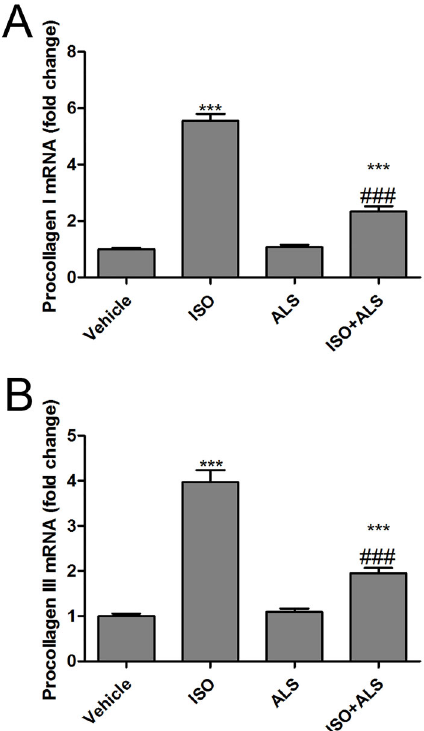
Figure 3. Canonical markers of cardiac fi brosis in response to aliskiren (ALS) in isoproterenol (ISO)-treated rats. The mRNA expression of ( A ) procollagen I and ( B ) procollagen III was measured by RT-qPCR in the left ventricles of the rats (n=6 per group). Data are reported as means ± SE. ***P o 0.001 compared with vehicle; ### P o 0.001 compared with the ISO group (ANOVA followed by Tukey ’ s post hoc